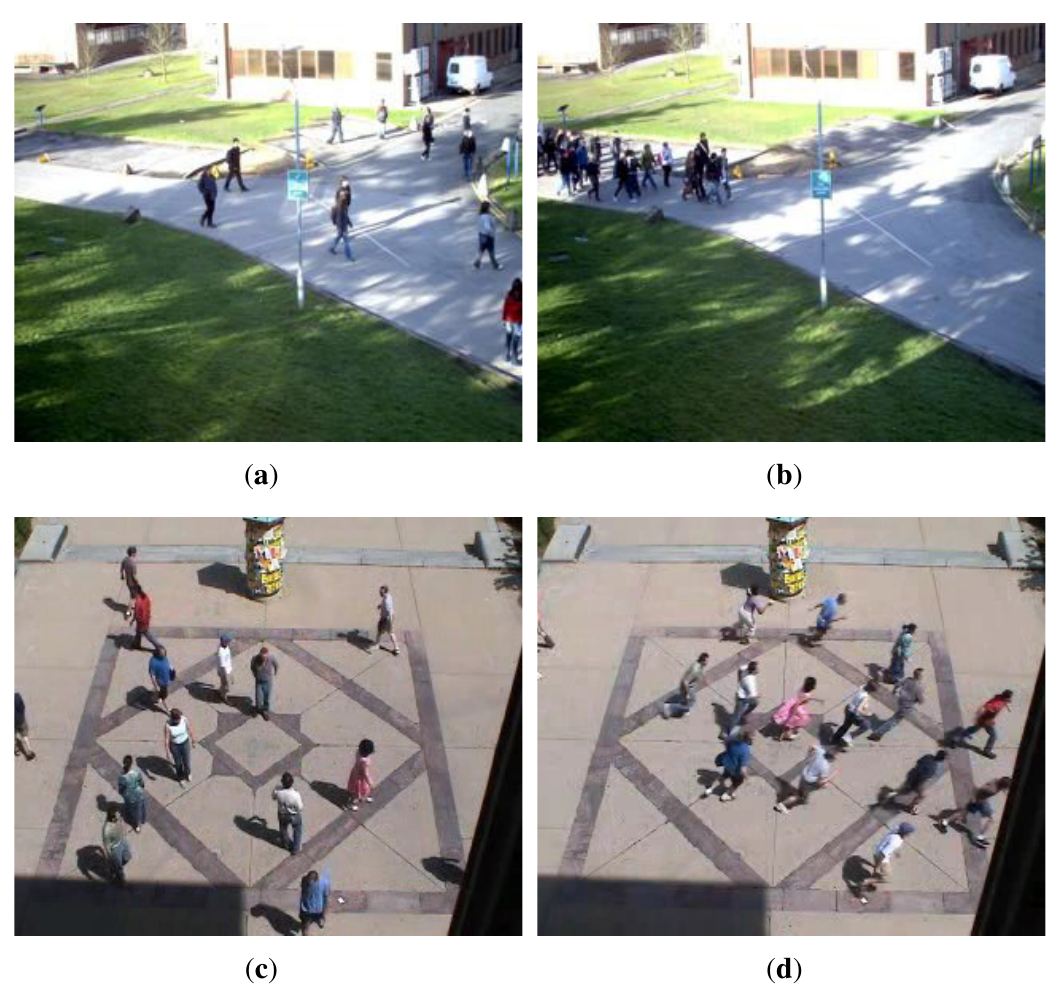
Figure 1. Normal and abnormal frames: ( a , c ) normal frames in the PETS and UMN datasets; the individuals are walking in all directions; ( b ) PETS abnormal frame; the individuals are walking in the same direction; ( d ) UMN abnormal frame; the individuals are running in all